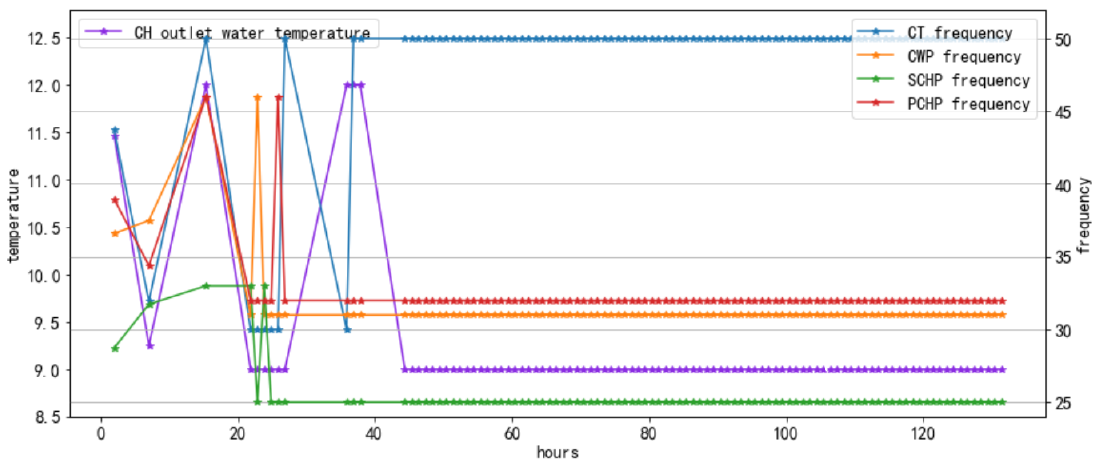
Figure 8. Setpoint variation process, corresponding to the upper-right Bayesian optimization process from Figure 6.